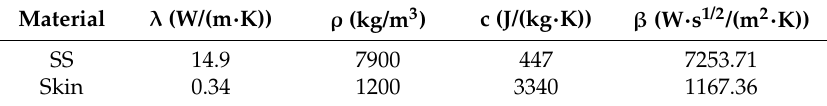
Figure 3. The temperature evolutions at thermoreceptors for different thicknesses of epidermis (Material = SS with absolutely smooth surface). SS—stainless steel. Table 1. Thermal properties of stainless steel (SS) and skin.